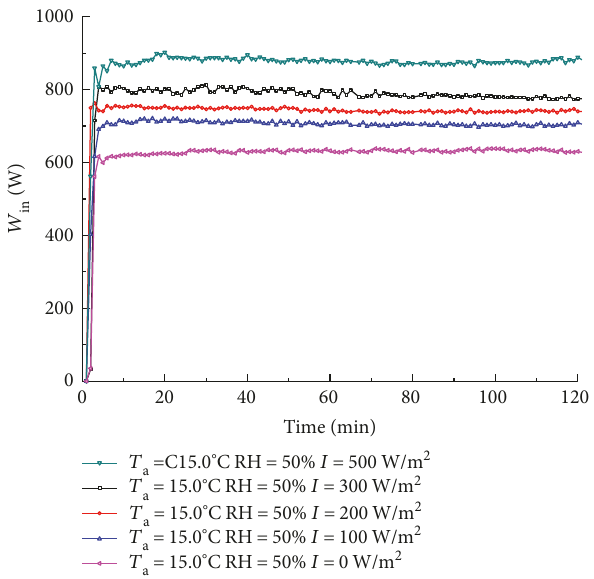
Figure 6: Variation of the evaporating and condensing heat exchange rate with solar irradiance of 0W m − 2 , 100 W m − 2 , 200 W m − 2 , 300W m − 2 , and 500W m − 2 .